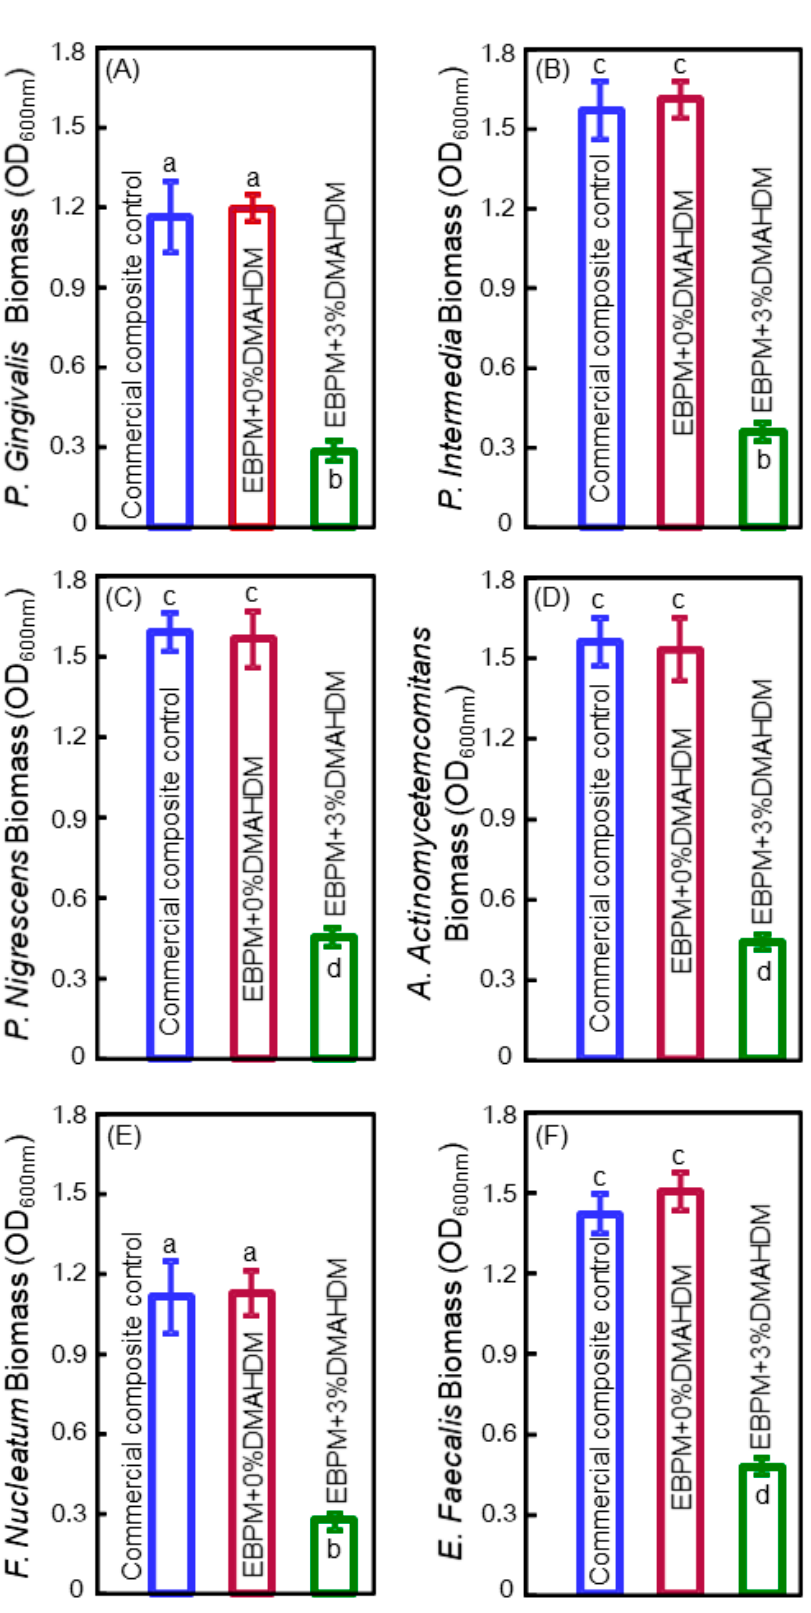
Figure 5. The biomass results of two-day biofilms grown on composites, evaluated using crystal violet assay and spectrophotometric optical density (OD600nm) (mean ± SD; n = 6): ( A ) P. gingivalis , ( B ) P. intermedia , ( C ) P. nigrescens , ( D ) A. actinomycetemcomitans , ( E ) F. nucleatum and ( F ) E. faecalis . The